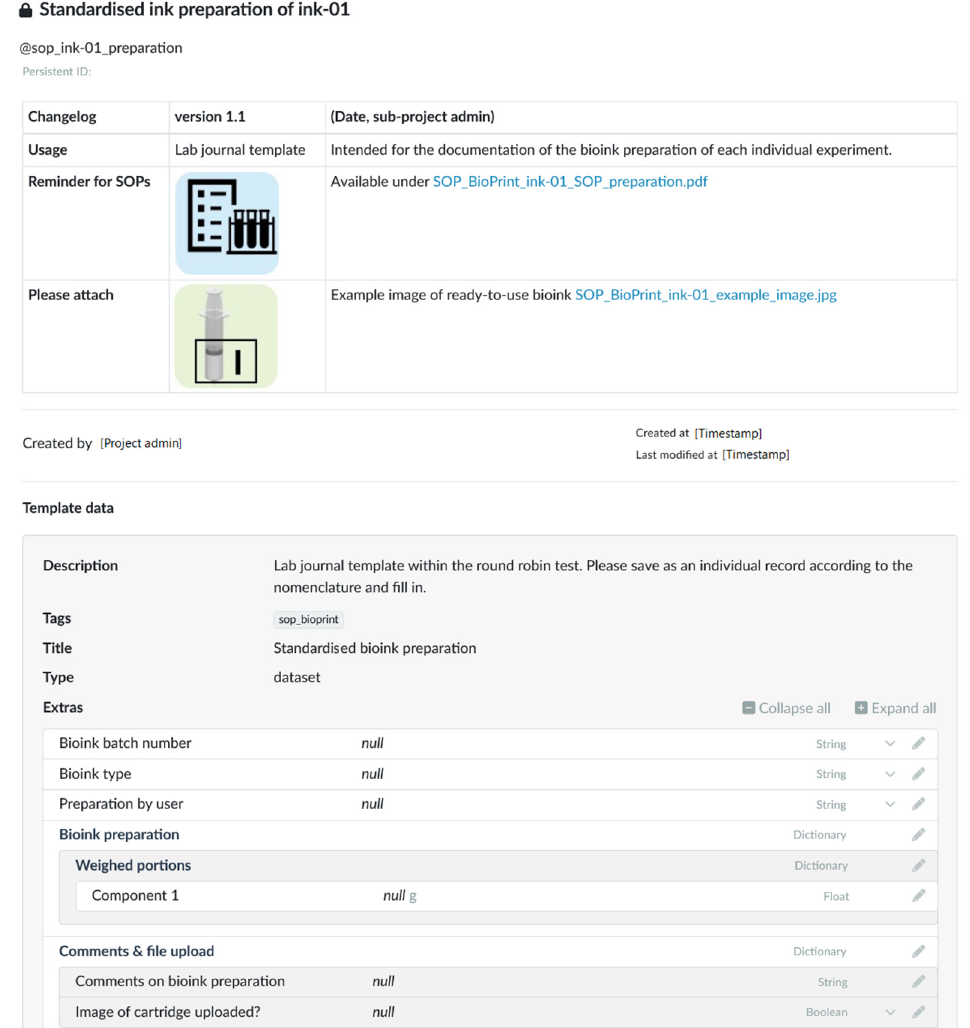
Figure 2. Screenshot of a record template in Kadi4Mat for the documentation of bioink preparation where personal data has been removed. The upper half of the template shows its title and instructions, while the actual template data can be seen in the lower half. The latter contains both fixed metadata types, such as the description and type of a record, as well as generic metadata entries, including their keys, types and additional validation instructions.